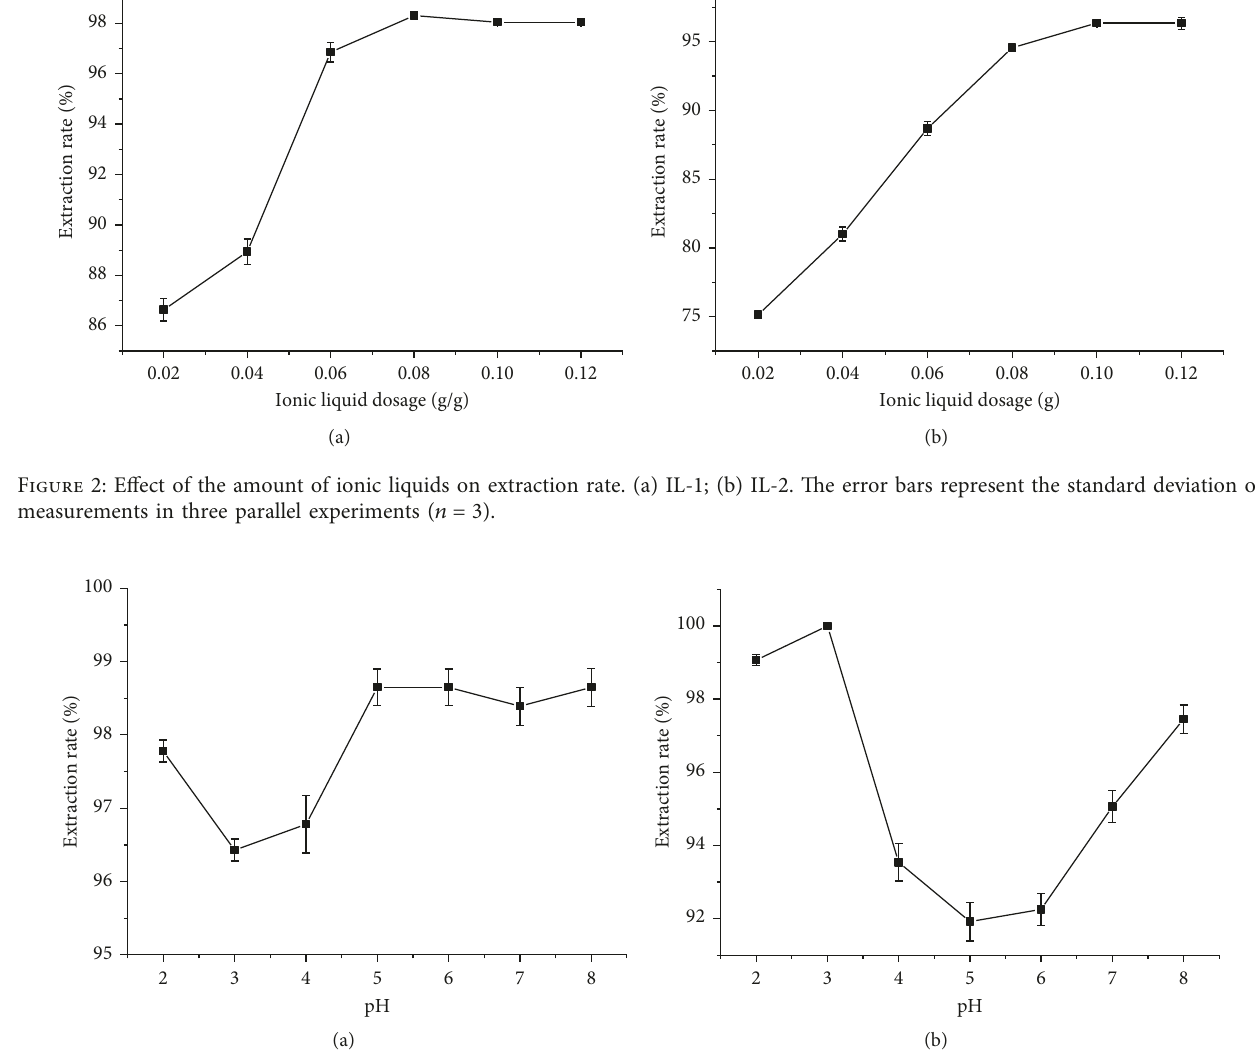
Figure 3: Effect of the pH on extraction rate. (a) IL-1; (b) IL-2. The error bars represent the standard deviation of measurements in three parallel experiments ( n �